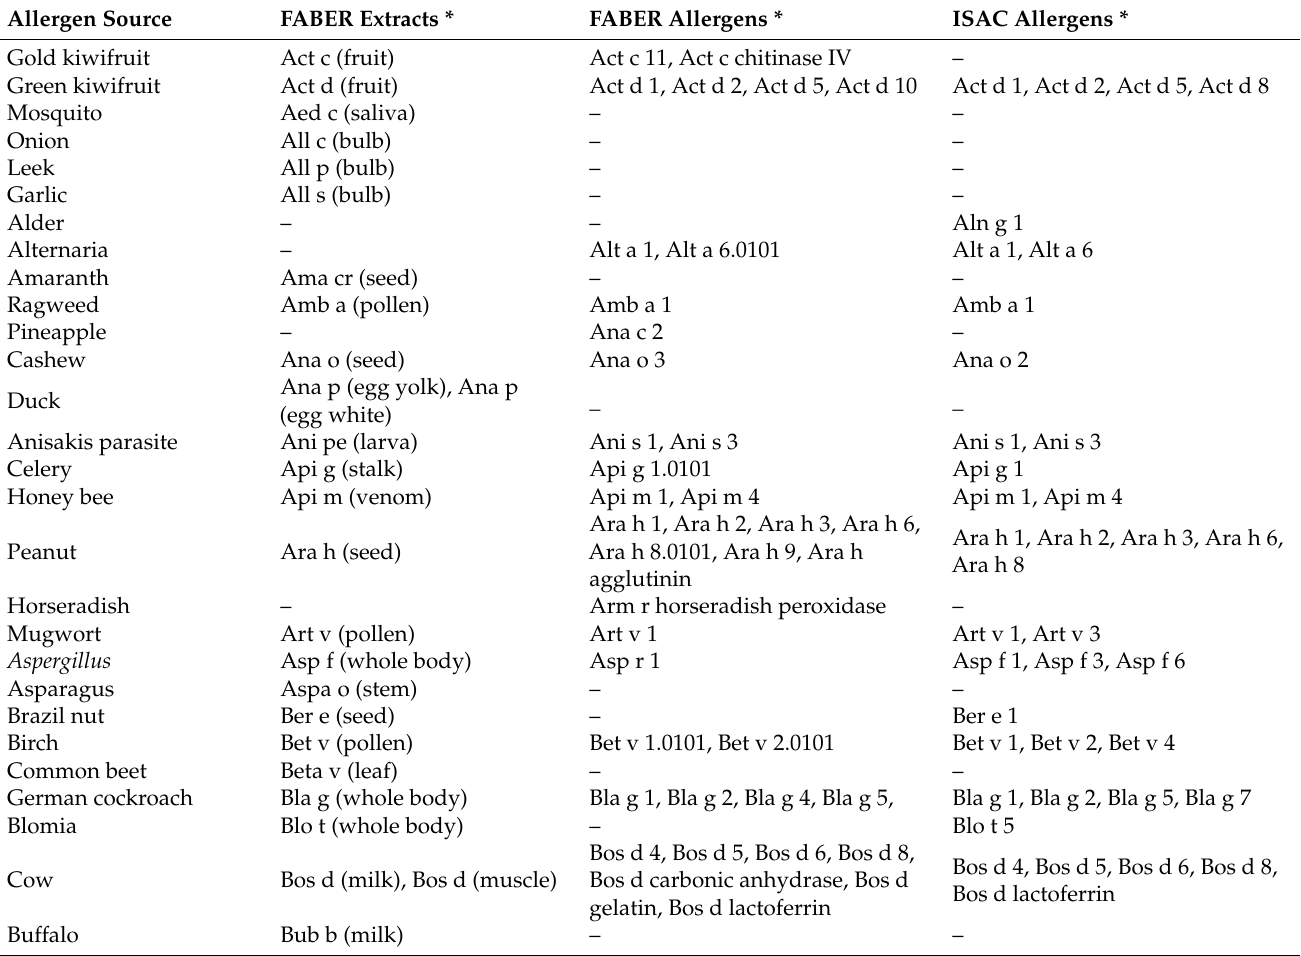
Table 2. List of 122 allergenic extracts and 122 purified allergens contained in the FABER microarray, and 112 purified allergens contained in the ISAC